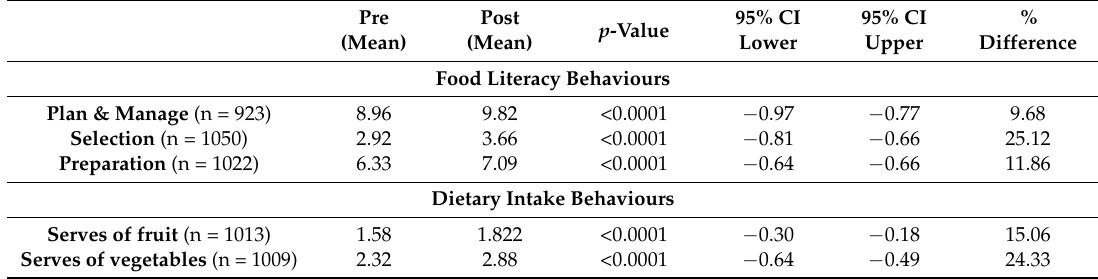
Table 2. Paired t -tests comparing pre- and postprogram factor scores for the three food literacy behaviour factors and change in self-reported dietary intake of fruit and vegetables.